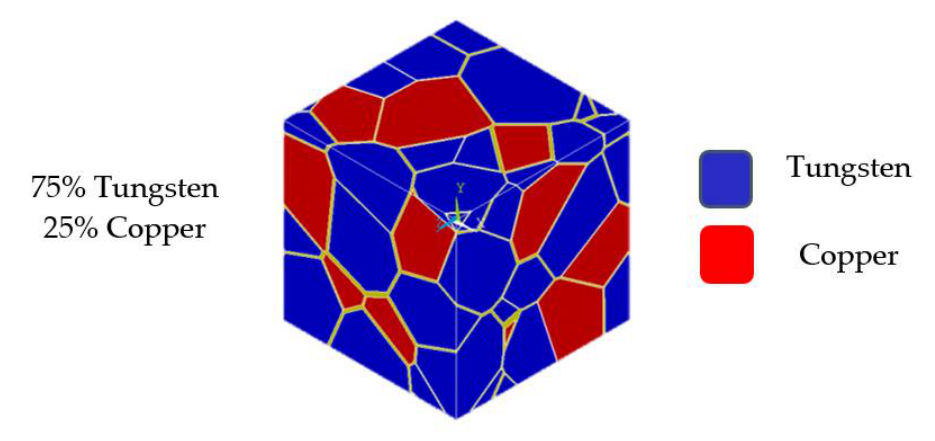
Figure 4. The representative volume element of a tungsten – copper nanocrystalline alloy.